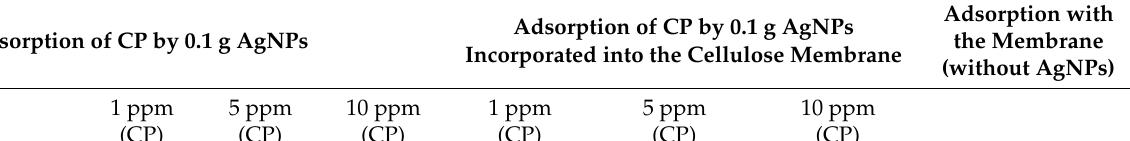
Table 2. % Adsorption of Cypermethrin (CP) insecticide by free AgNPs and AgNPs incorporated into a cellulose membrane, as a function of the initial insecticide